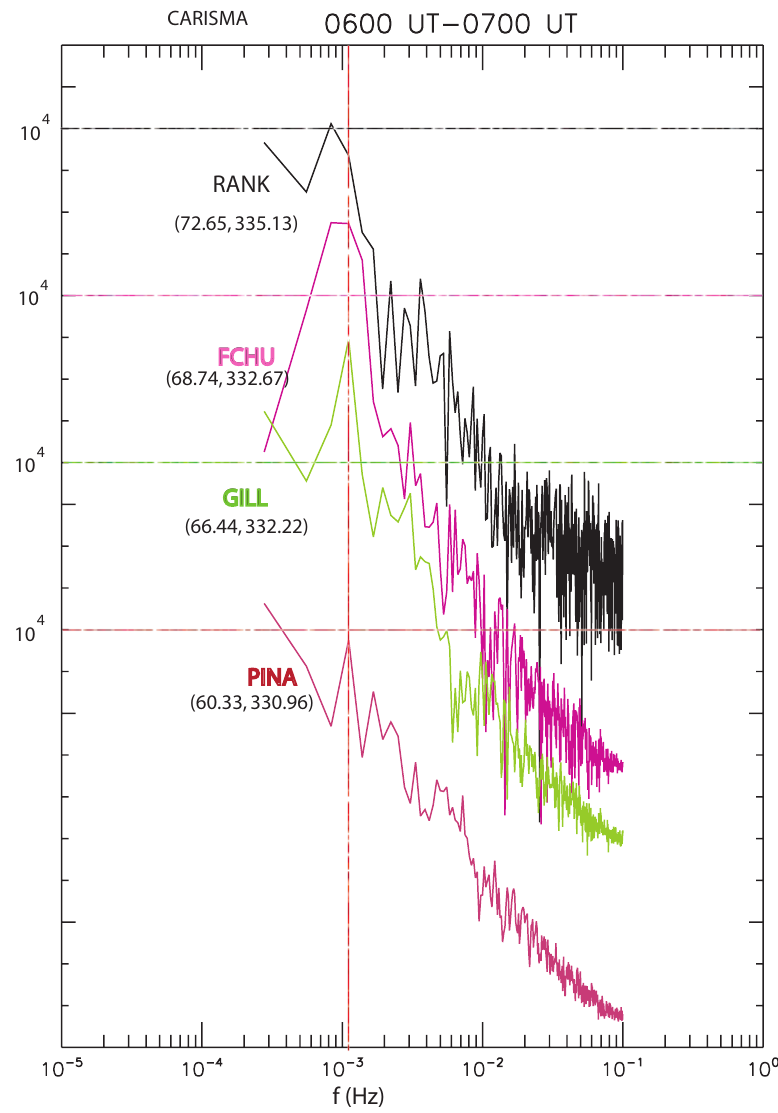
Fig. 6. The power spectra along the north-south Churchill line using the data within the one-hour interval 06:00–0700 UT.